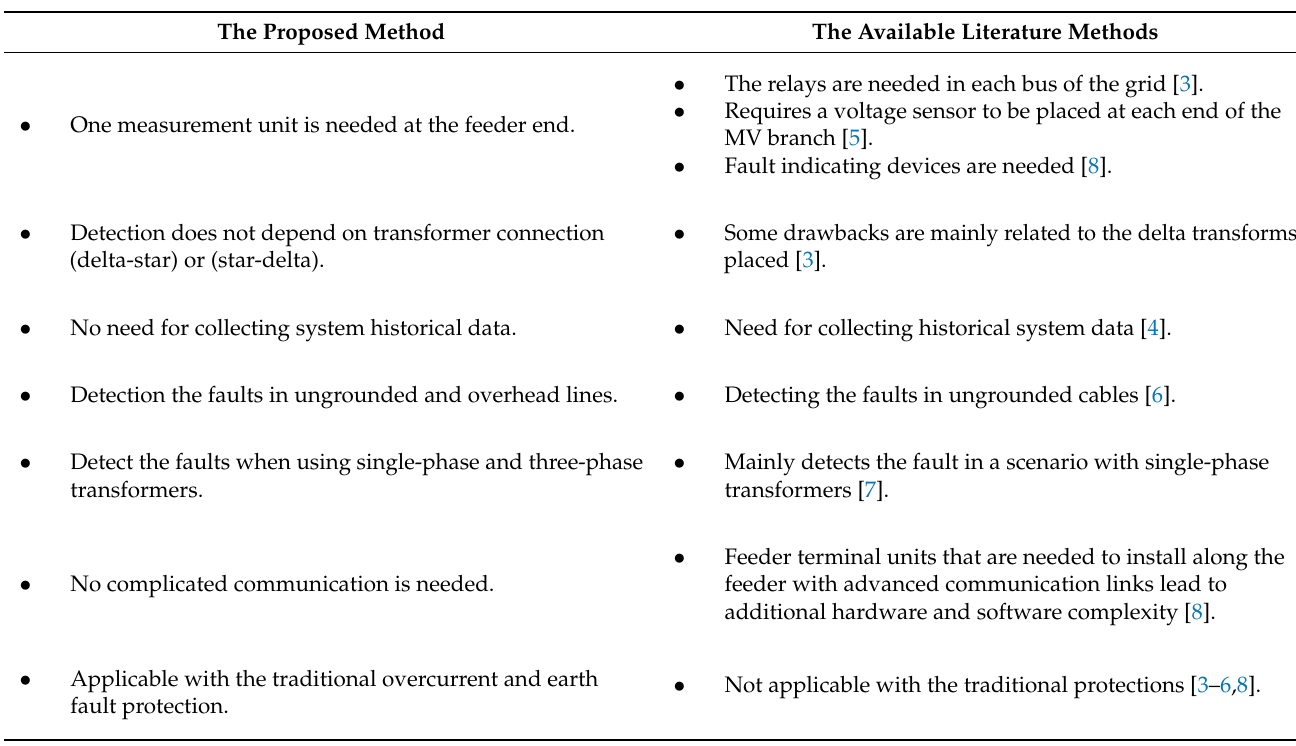
Table 5. Comparison between the proposed method with recent